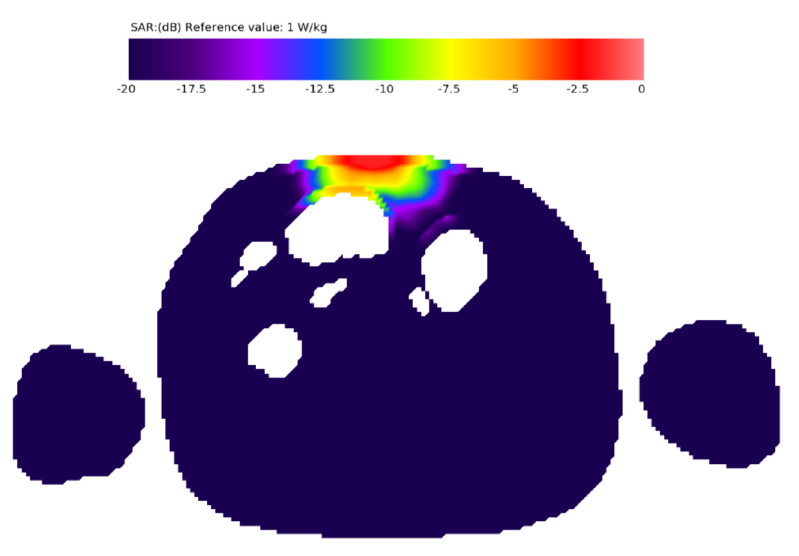
Figure 16. The distribution of Specific Absorption Rate (SAR) parameter in the cross-section of human body model, at the position of antenna for 3.5 GHz.